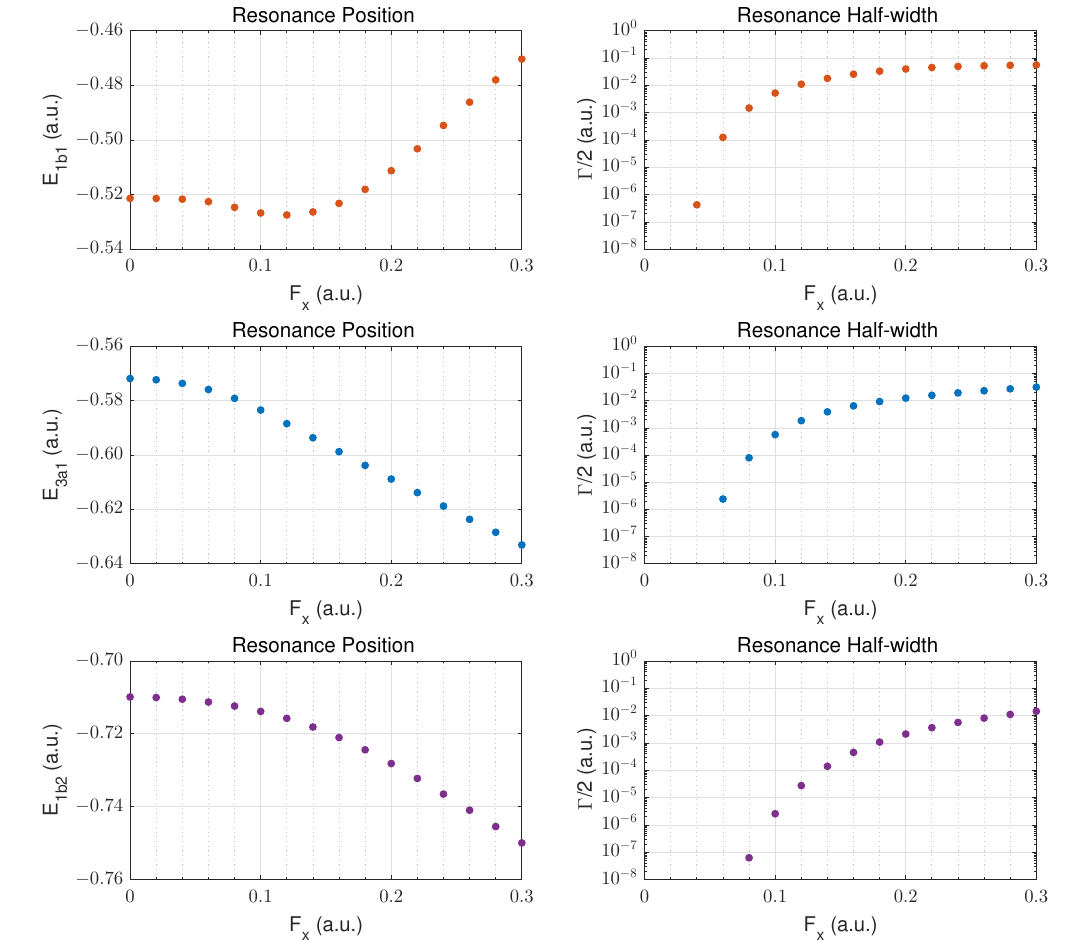
Figure 4. The left panel contains the resonance positions while the right panel contains half-widths for the valence orbitals of water in a DC field. Here, F x > 0 corresponds to a force experienced by the electron in the positive x